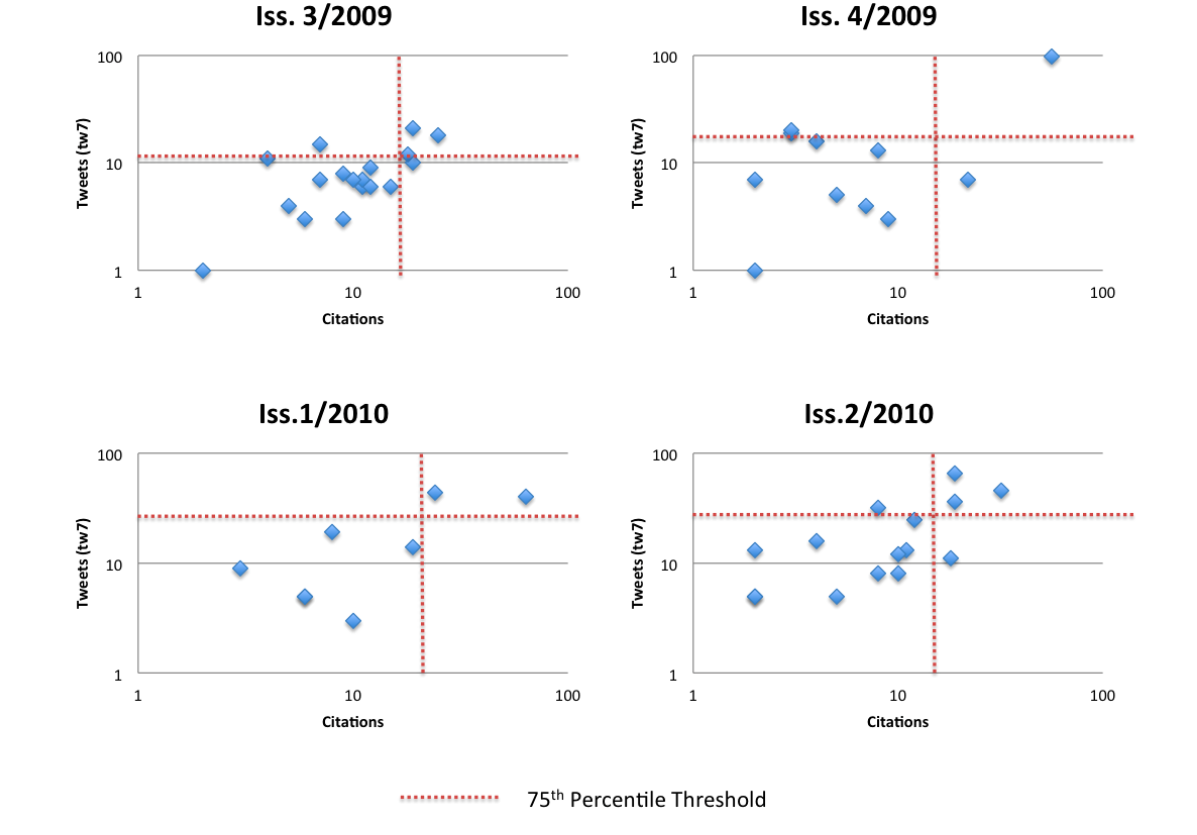
Figure 10. Correlations between citations in November 2011 (Google Scholar) and the cumulative number of early tweets by day 7 (tw7). Note the logarithmic scale. Articles with 0 tweets or 0 citations are not displayed here, because the log of 0 is not defined. However, conceptually they all fall into the lower left quadrant.